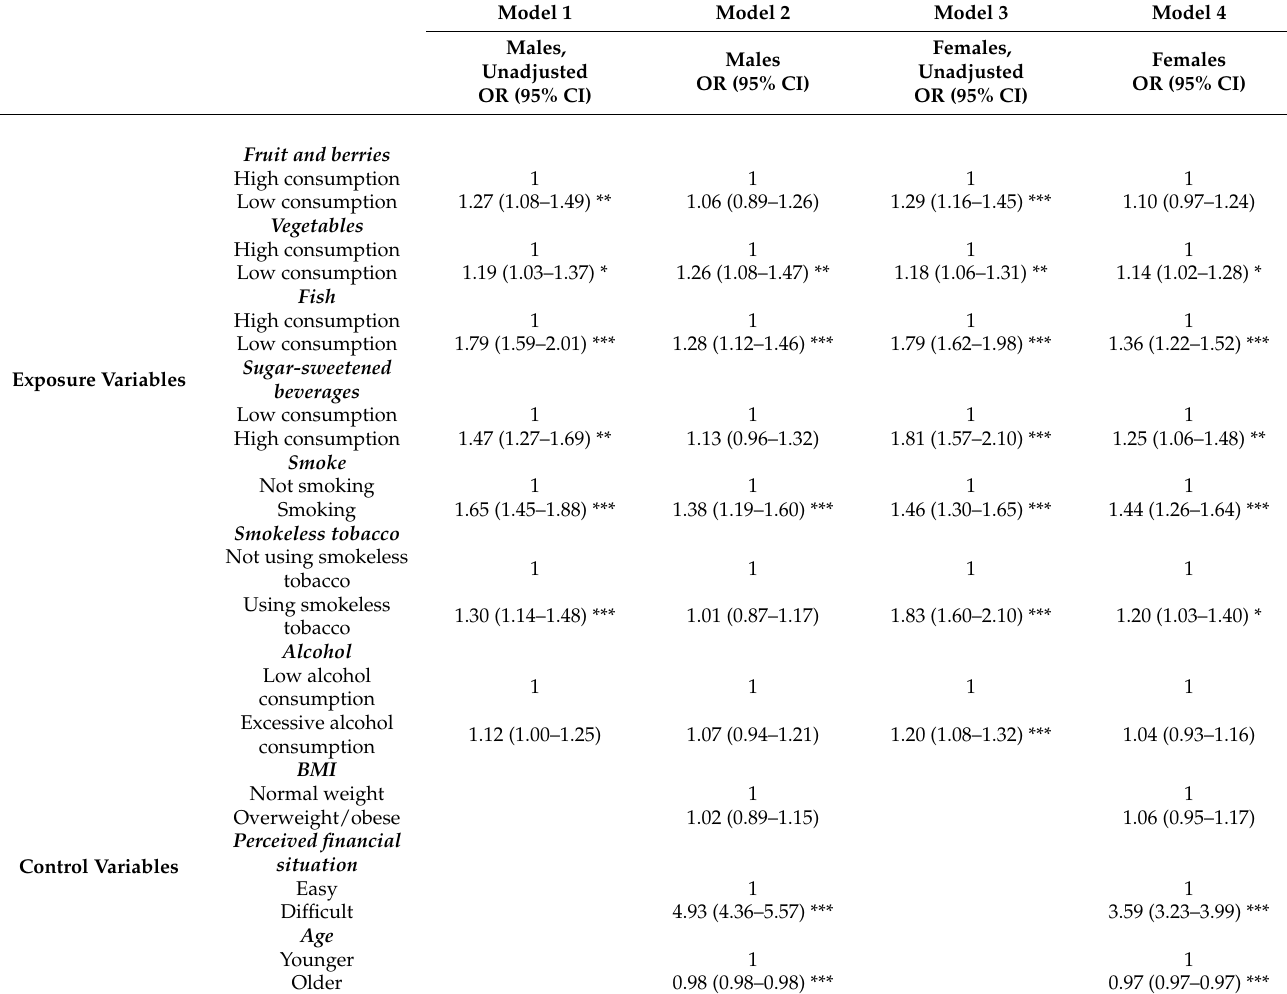
Table 4. Logistic regression describing the association between lifestyle behaviors and mental distress among